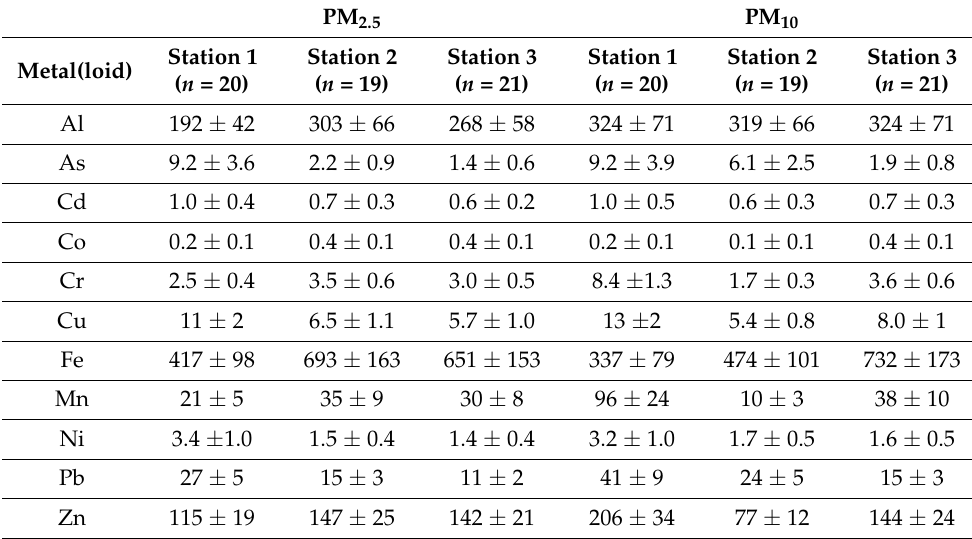
Table 3. The annual average concentrations (ng/m 3 ) of metal(loid)s in PM 2.5 and PM 10 at recording stations in Chelyabinsk. PM 2.5 PM 10